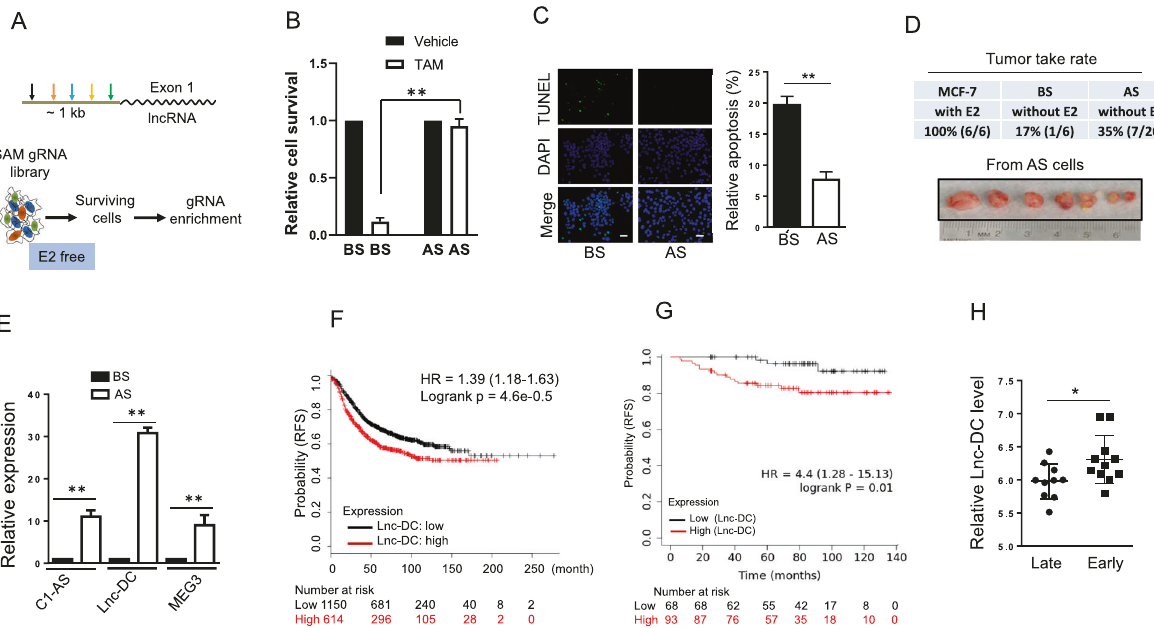
Fig. 1 Identi fi cation of Lnc-DC as a potential lncRNA involved in estrogen independency and tamoxifen resistance. A Design for SAM gRNAs and procedure for SAM library screen. B Responses of cells before selection (BS) and after selection (AS) to tamoxifen. The cells were treated with 10 μ M tamoxifen for 3 days before relative cell survival was determined by MTT assay. C Suppression of tamoxifen-induced apoptosis in AS cells, as determined by TUNEL assay. Relative apoptosis was shown on the right. D AS cells result in a higher tumor